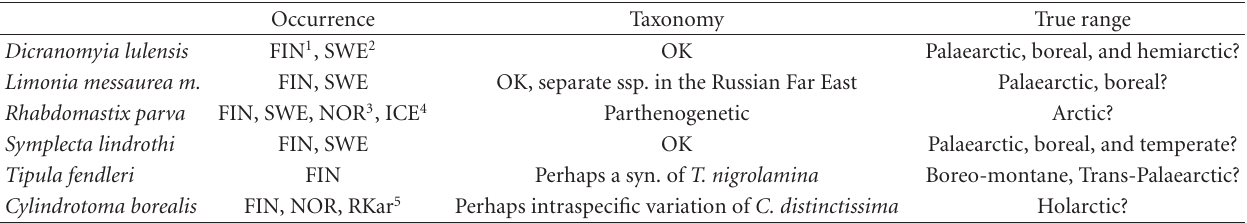
Table 5: “Endemic” Fennoscandian crane fly (Diptera, Tipuloidea) species occurring in Finland, their current and predicted ranges and notes on taxonomic status of each species. See the text for